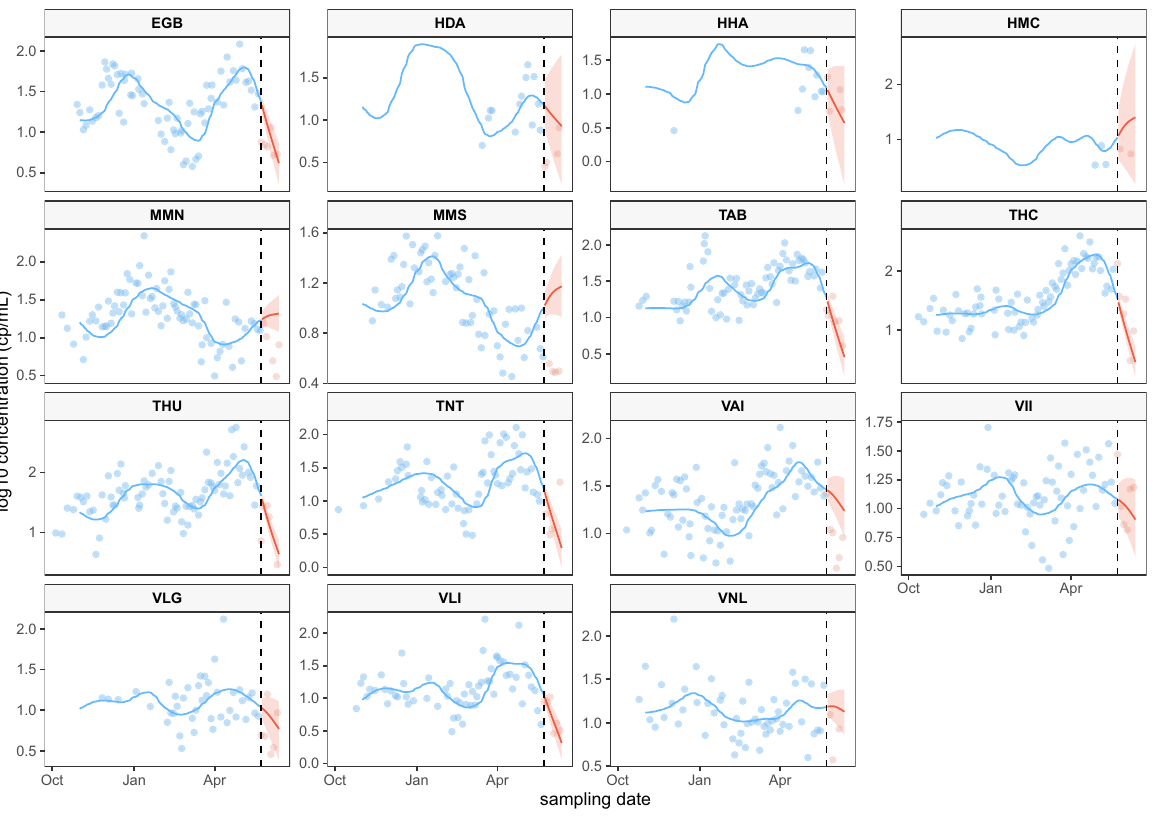
Figure 3. The historic data observed before May 23rd, 2021 (blue points) are used as training data and used to fit the full model (blue line represents the mean posterior curve). The mean posterior curve beyond the last observation date used for fitting is shown in red (red area for the 95% CrI). The red points represent the data forecasted. The forecasting horizon is one calendar month.